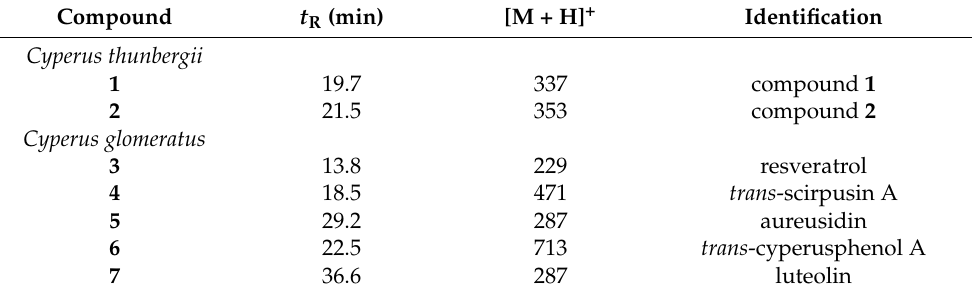
Table 1. Identification of compounds using retention times and electrospray ionization mass spec- troscopy (ESIMS)